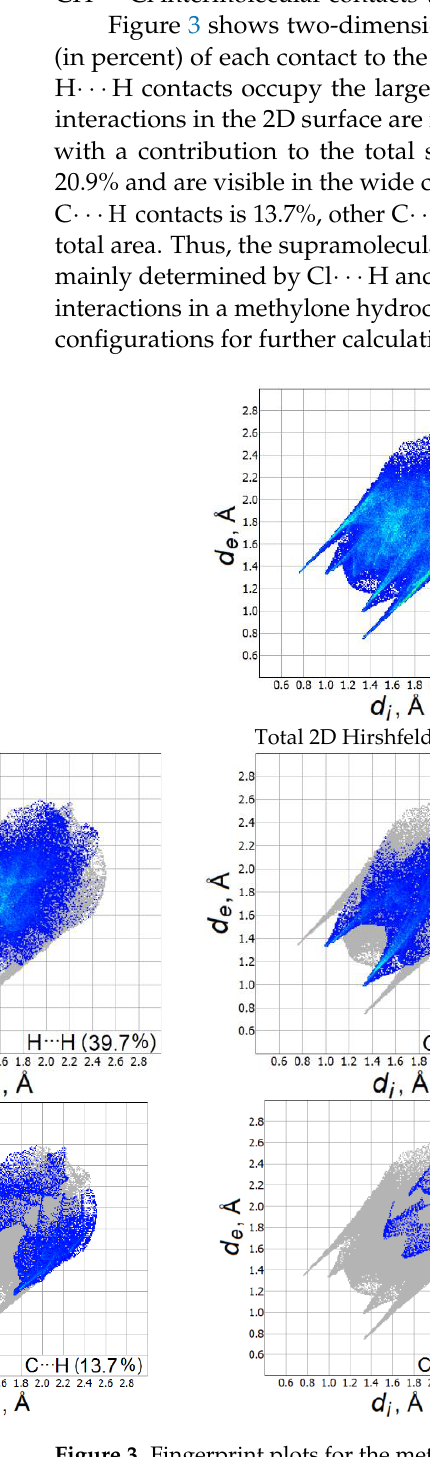
Figure 3. Fingerprint plots for the methylone hydrochloride crystal (the d e and d i correspond to the external and internal distances, respectively).